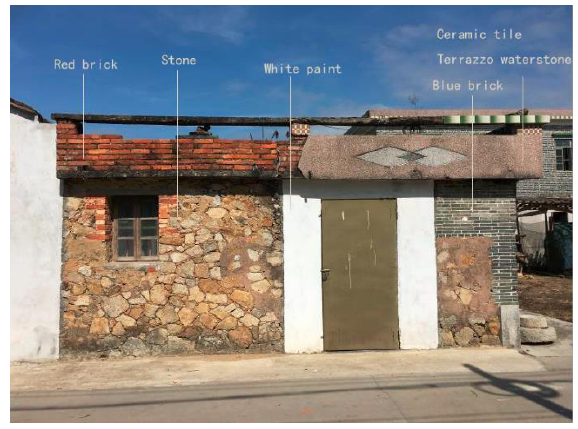
Figure 13. Material mixture (source: the authors).